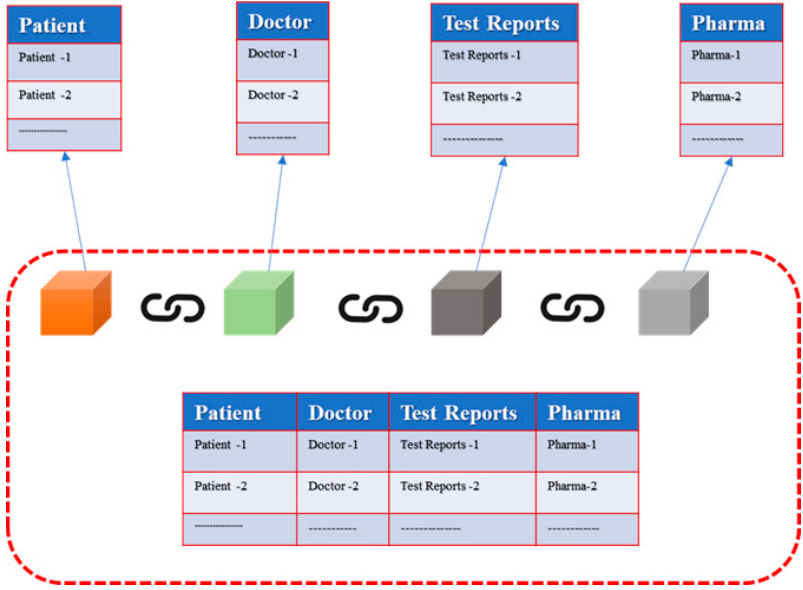
Figure 3. Decentralized Blockchain-based smart contracts for an IoMT framework in e-healthcare. Working of Blockchain Based Smart Contracts for IoMT in e-Healthcare